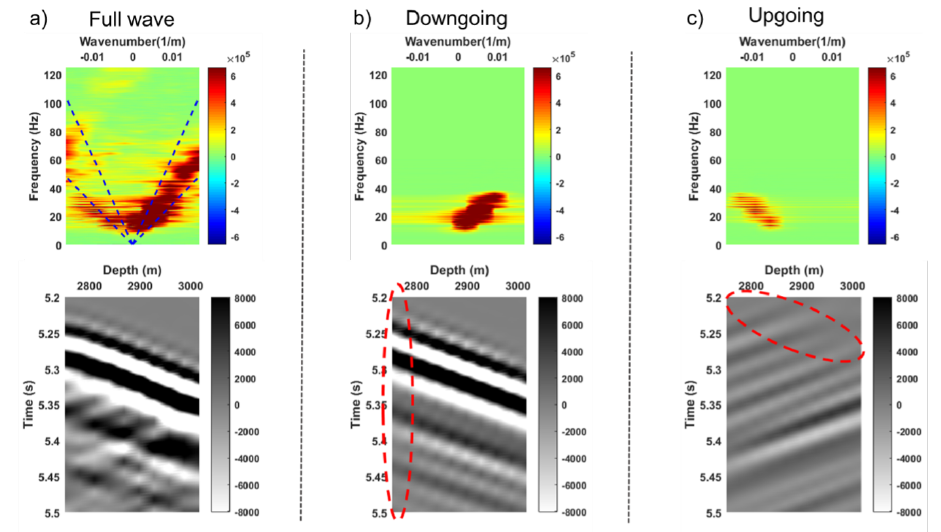
Figure 13. Wavefield separation of check shot data in the f - k domain. ( a ) The up- and downgoing wavefield and its f - k spectrum. ( b ) The downgoing wavefield and its f - k spectrum. Red-dashed circle shows poorly resolved events at the seismic section boundary. ( c ) The upgoing wavefield and its f - k spectrum. Red-dashed circle shows the area that contains artifacts of the f - k filter above the first-order downgoing wave.